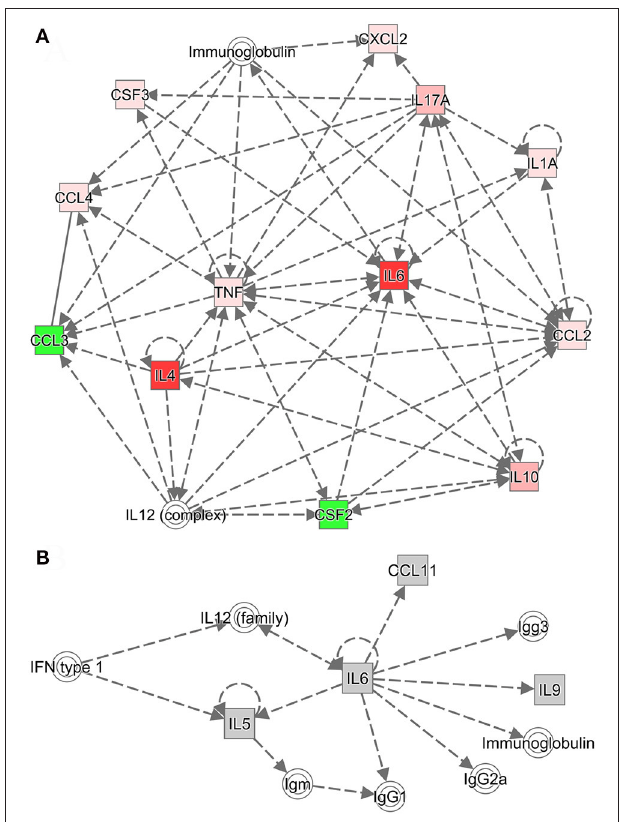
FIGURE 6 | Cytokine networks were evaluated using Ingenuity Pathway Analysis (IPA). (A) The cytokine network according to IPA includes upregulated cytokines and their interactions. (B) The network connects the most upregulated cytokines and immunoglobulin G subclasses in the serum. Dotted lines indicate indirect associations.